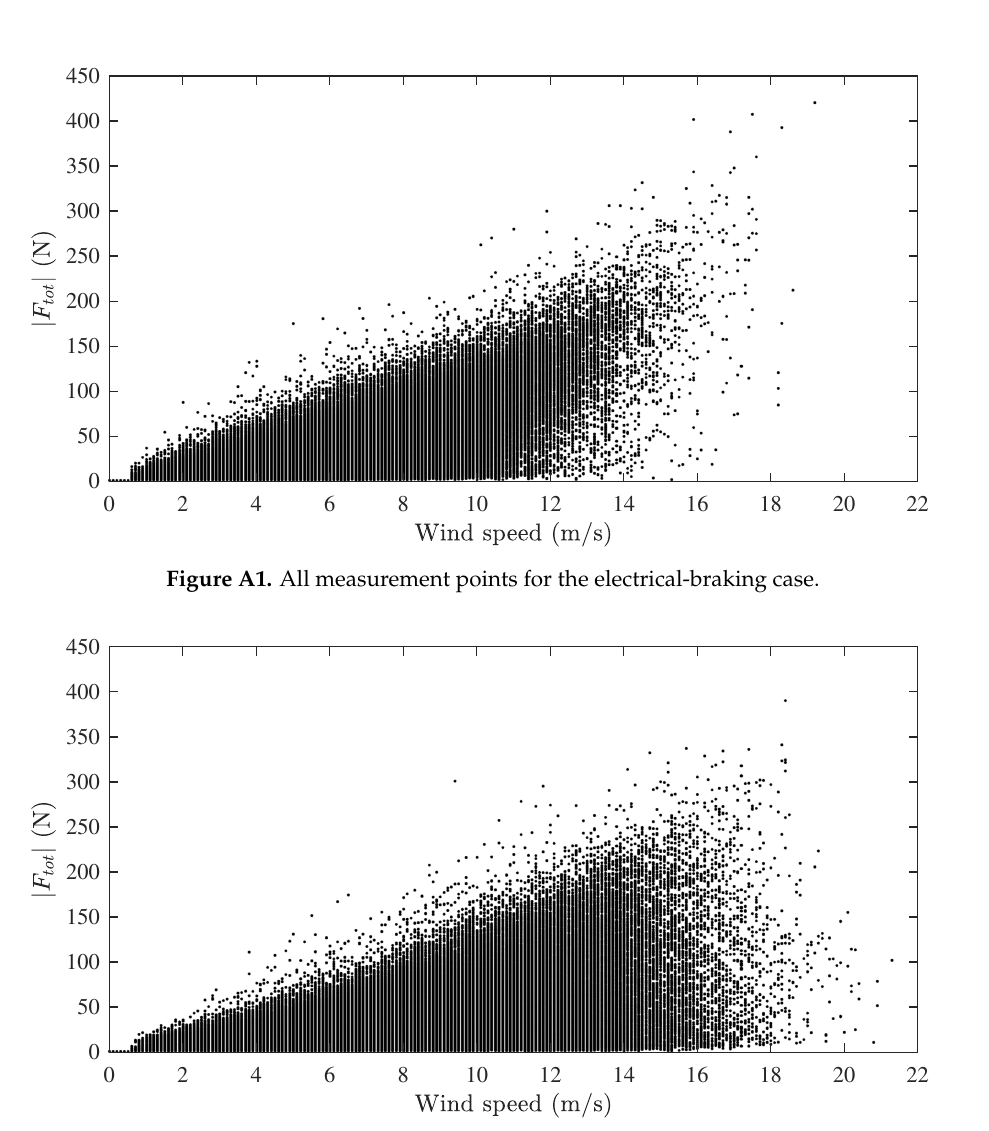
Figure A2. All measurement points for the mechanically-fixed